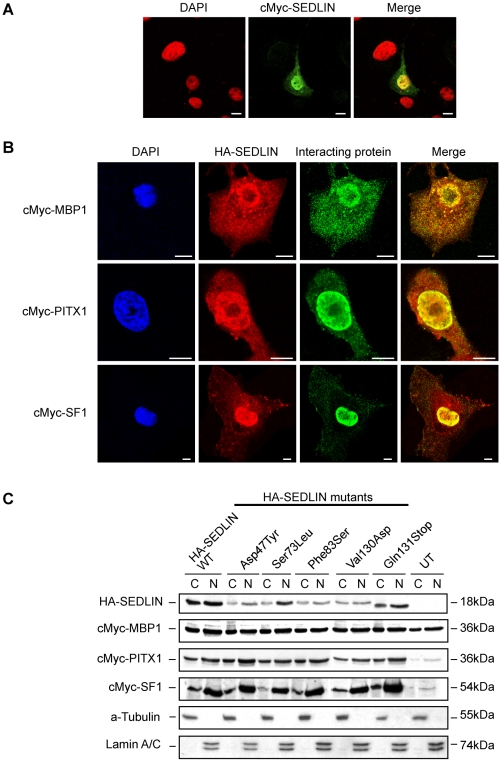
Subcellular co-localization of wild-type and mutant SEDLINs, MBP1, PITX1 and SF1.(A) COS7 cells were transfected with wild-type or mutant (Asp47Tyr, Ser73Leu, Phe83Ser, Val130Asp and Gln131Stop) cMyc-SEDLIN constructs and visualised by immunofluorescence. The wild-type cMyc-SEDLIN (green) and mutant forms (data not shown) were found to localize to the nucleus and cytoplasm. DAPI, which stains nuclei (shown as red), colocalized with SEDLIN (yellow in merged image). (B) Wild-type or mutant HA-SEDLINs (red) were co-transfected with cMyc-MBP1, cMyc-PITX1 or cMyc-SF1 constructs and visualized by immunofluorescence (green). Wild-type SEDLIN and mutant SEDLINs (data not shown) co-localized (yellow) to the nucleus with the three transcription factors and to punctate structures within the cytoplasm with MBP1. (C) Western blot analysis of subcellular fractions (N - nuclear, C–cytoplasmic) from COS7 cells transiently co-transfected with wild-type (WT) or one of the 5 mutant HA-SEDLIN constructs, and cMyc-MBP1, cMyc-PITX1 or cMyc-SF1 constructs. Use of anti-HA antibody detected the expected 18 kDa wild-type and mutant SEDLIN proteins, and anti-cMyc antibody detected the expected 36 kDa, 36 kDa and 54 kDa MBP1, PITX1 and SF1 proteins, respectively, which were seen in the nuclear and cytoplasmic fractions, thereby confirming the immunofluorescence results. Western blots with anti-α-Tubulin and anti-Lamin A/C antibodies confirmed that the nuclear and cytoplasmic fractions were free from detectable amounts of cytoplasmic and nuclear fractions, respectively. Untransfected (UT) cells-not transfected with HA-SEDLIN. Wild-type and mutant SEDLINs were found in the nuclear and cytoplasmic fractions, and the SEDLIN mutants did not lead to an altered subcellular localization of MBP1, PITX1 and SF1. Scale bars, 10 µm.